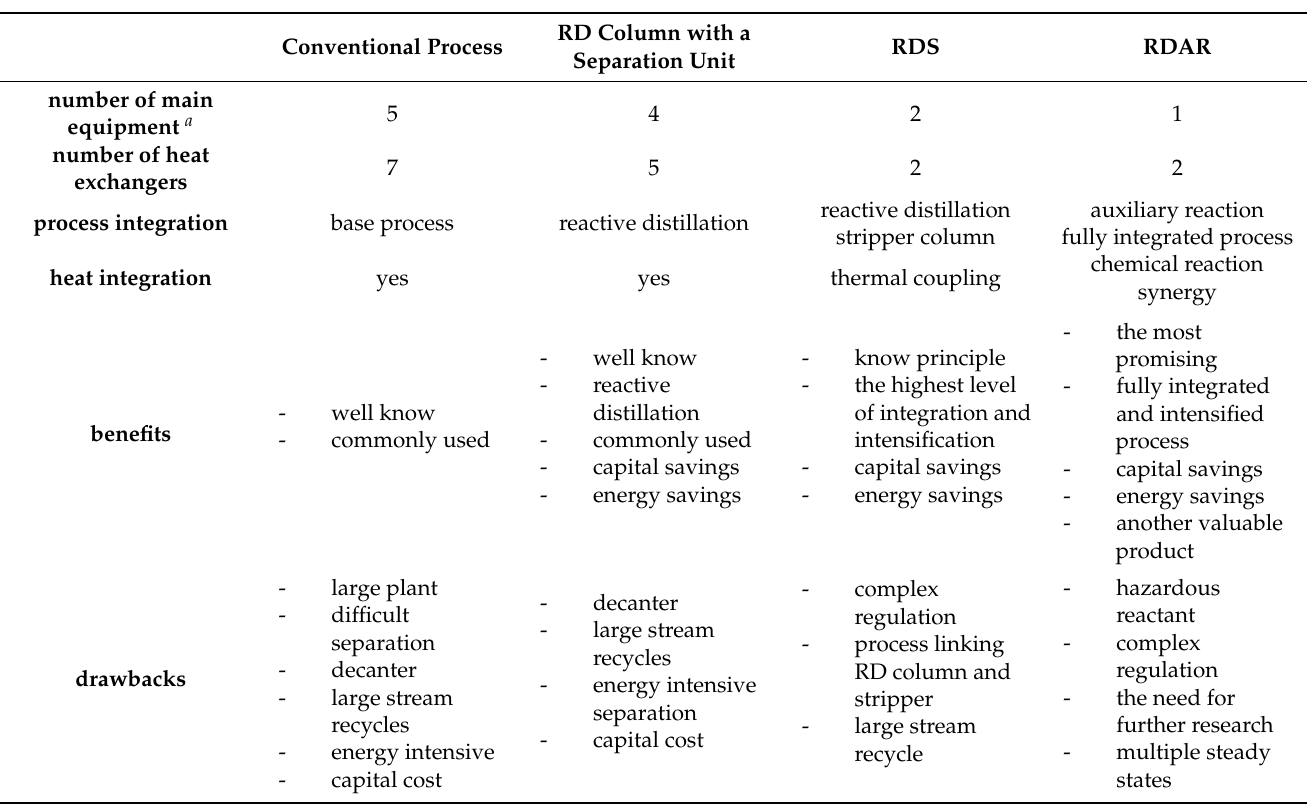
Table 2. Summary of ethyl acetate production pathways from our previous work [5]; number of main equipment, process integration, benefits,